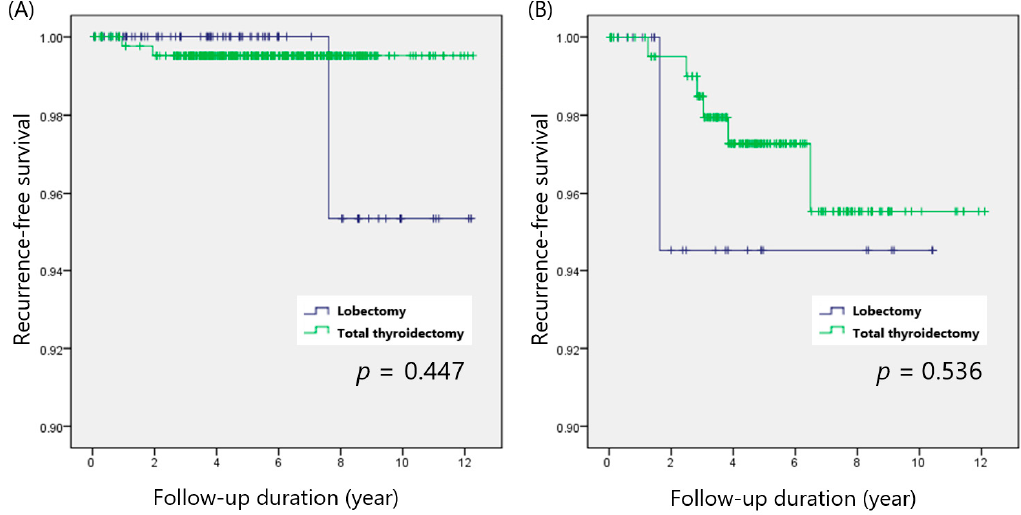
Figure 3. Recurrence-free survival in patients with ( A ) node-negative and ( B ) node-positive PTC.